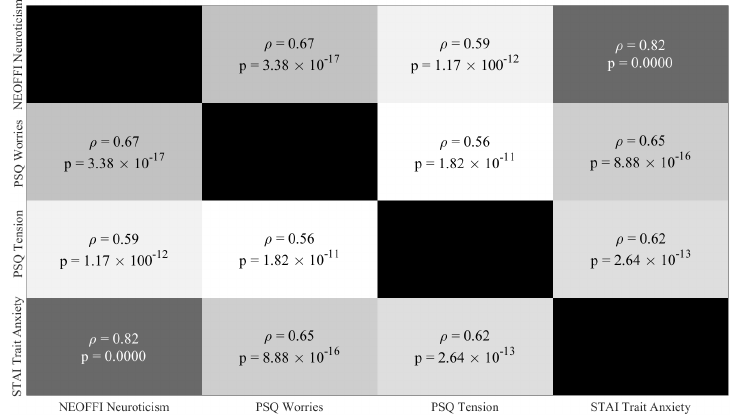
Figure A8. Pair-wise partial (Spearman) correlations between neuroticism (NEO-FFI), worries (PSQ), tension (PSQ), and trait anxiety (STAI-G-X2) for all 122 participants who took parts in resting-state EEG recordings.